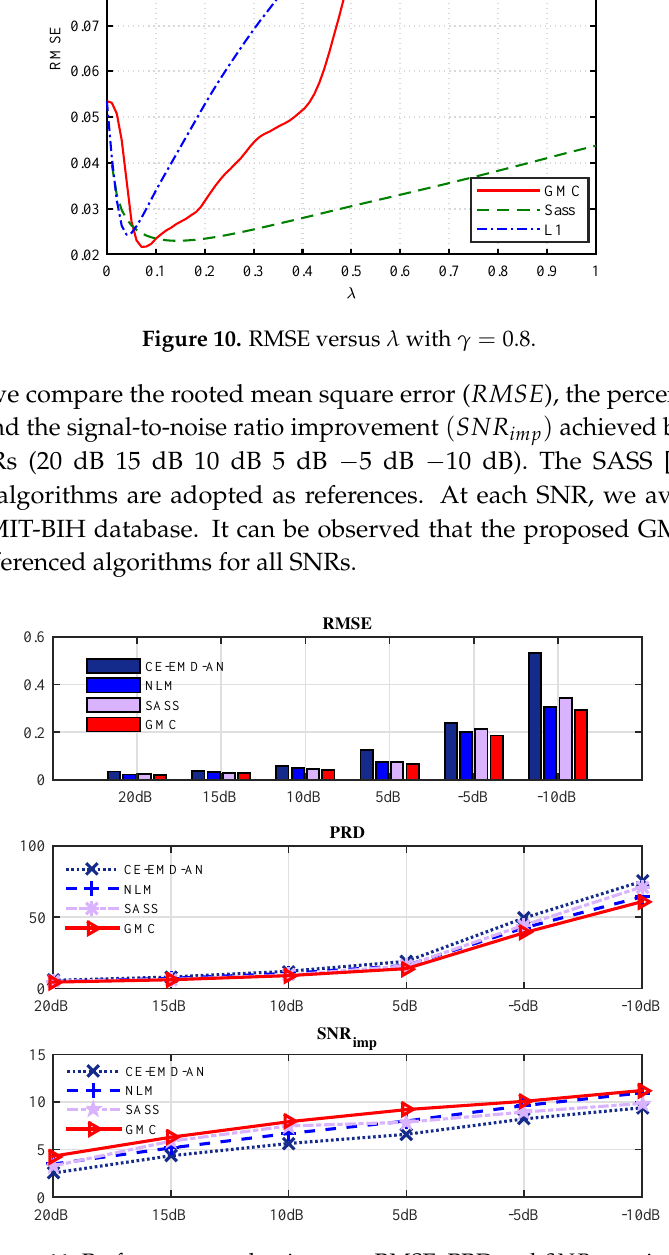
Figure 11. Performance evaluation over RMSE, PRD and SNR imp